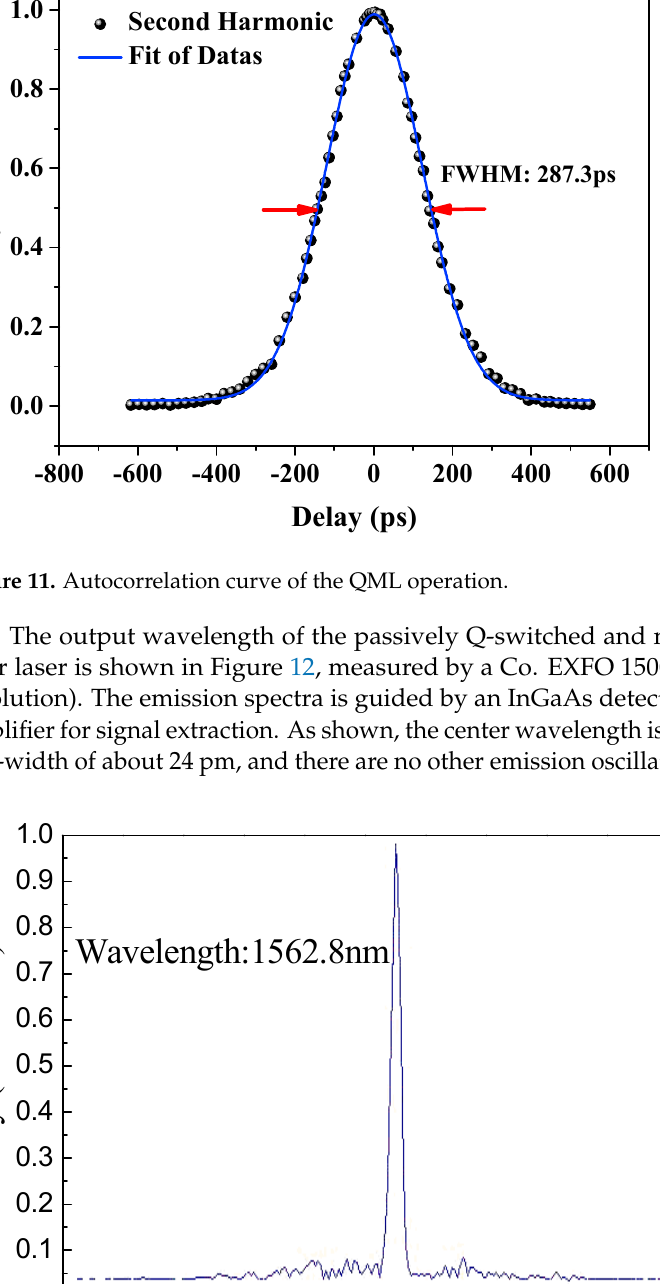
In addition, the autocorrelation measurement curve is shown in Figure 11 below. In Figure 11, black dots are the measured relative intensity data of the second harmonic, and the red line is the Gaussian fitting curve. The full wave at half maximum (FWHM) obtained from the autocorrelation curve divided by the conversion coefficient is equal to the mode-locked pulse width. For Gaussian curve fitting, the conversion coefficient is 1.414 [25]. As shown in Figure 11, the FWHM of the autocorrelation curve is 287.3 ps, so the width corresponding to the mode-locked pulse is about 203.1 ps.